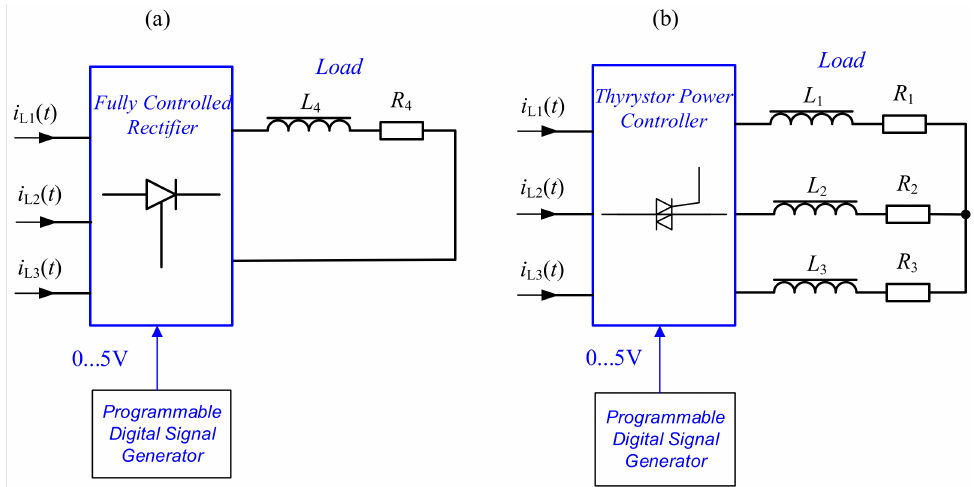
Figure 12. Three-phase nonlinear loads: ( a ) with fully controlled rectifier, ( b ) with thyristor power controller.